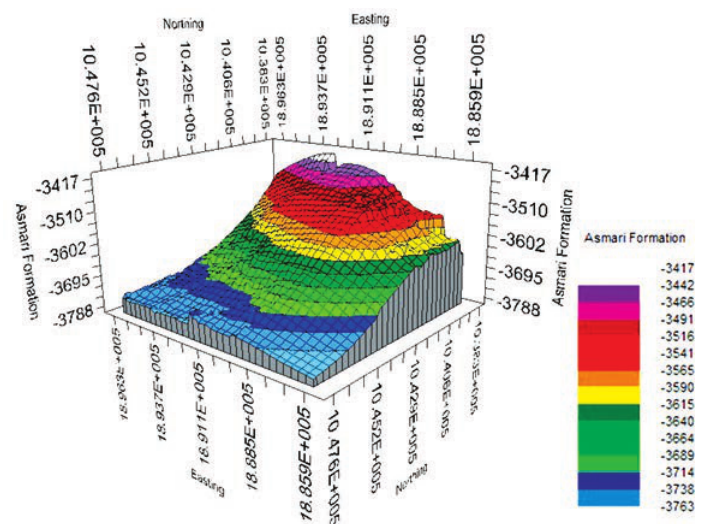
Fig. 8. Final model of the top of Asmari Formation (right